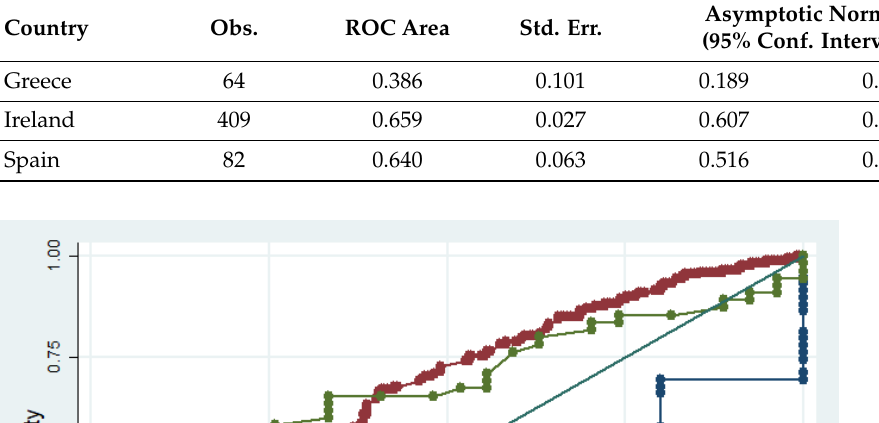
Table 12. Comparison of the ROC areas—country subsample models (firms).